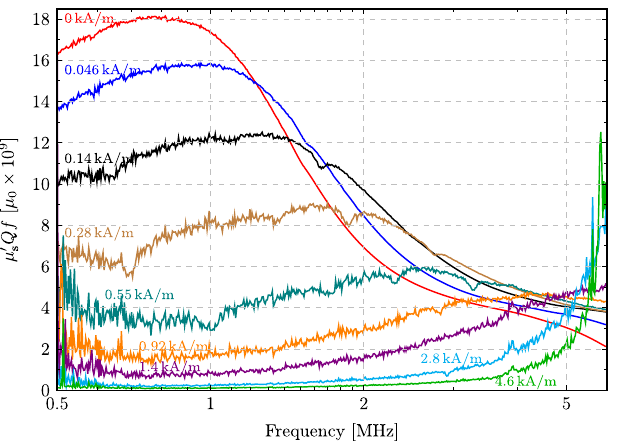
FIG. 11. B - H curve for the working cycle with reduced bias range measured at a frequency of 1 Hz. The solid line represents the characteristic functions (23) with parameters a ¼ 80 . 4 kA = m, b ¼ 0 . 0059 m = A, and M 83 . 7 kA = 0 ¼